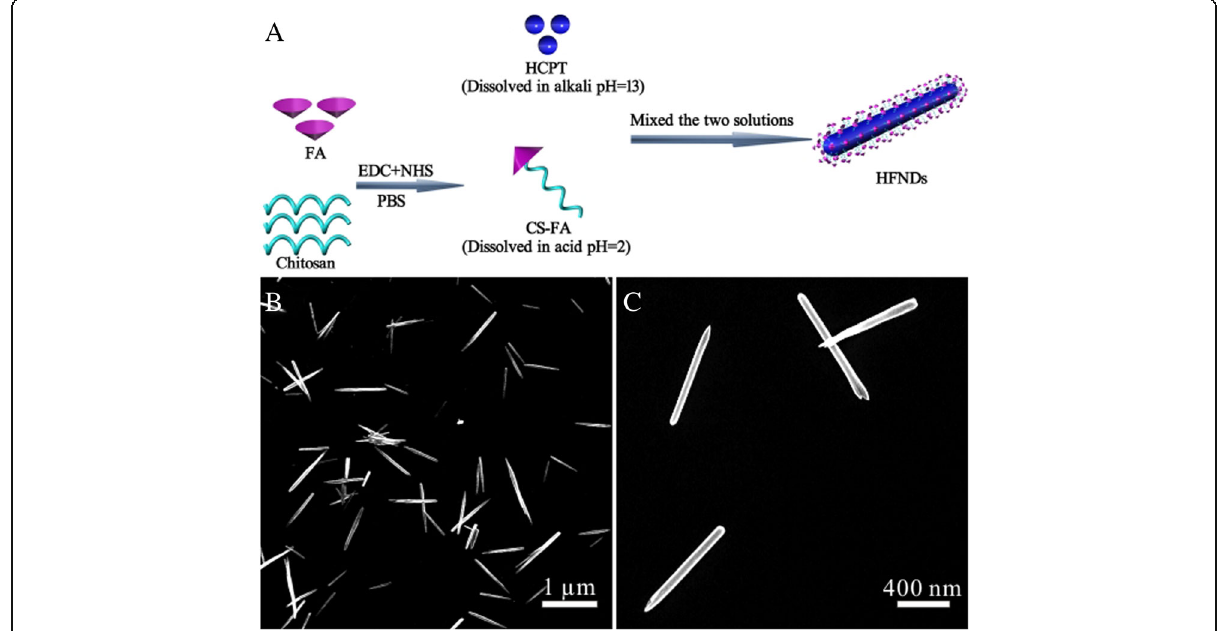
Fig. 3 a Illustration of the completely green method of preparing HFNDs. b , c The SEM images of HFNDs